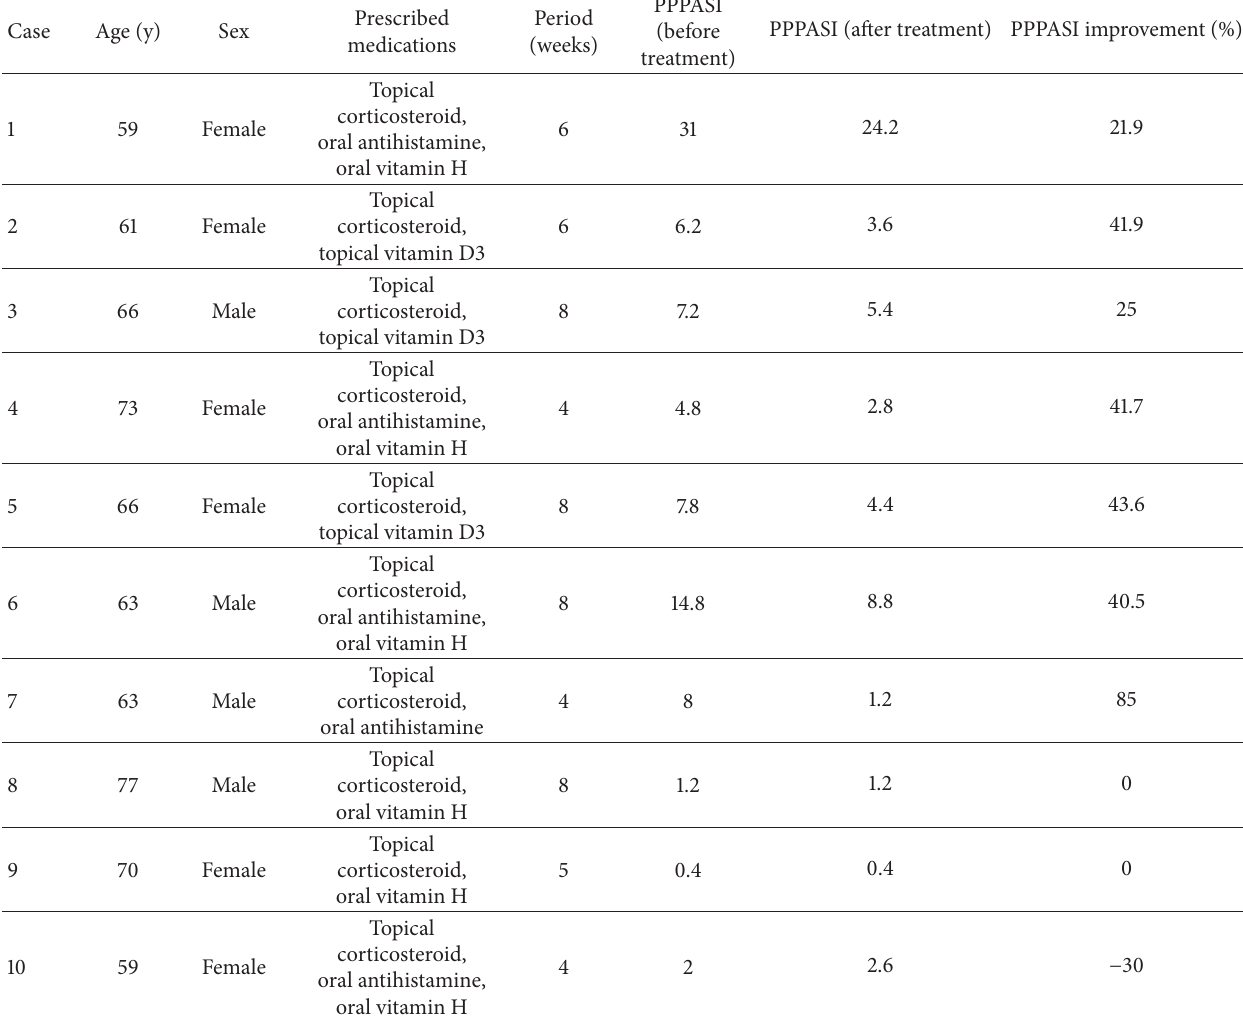
Table 1: Characteristics and evaluation of clinical symptoms in patients treated with